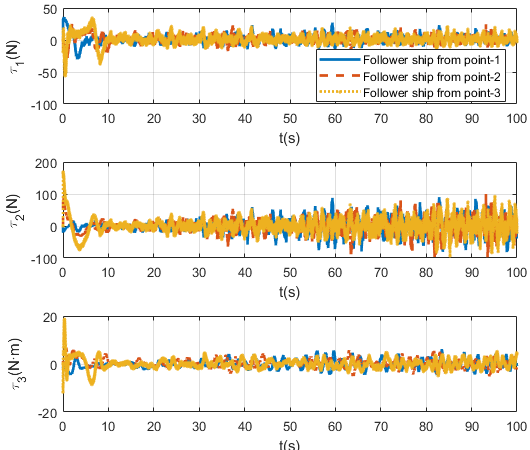
Figure 4. The responses of control inputs from disparate initial points with disturbances.